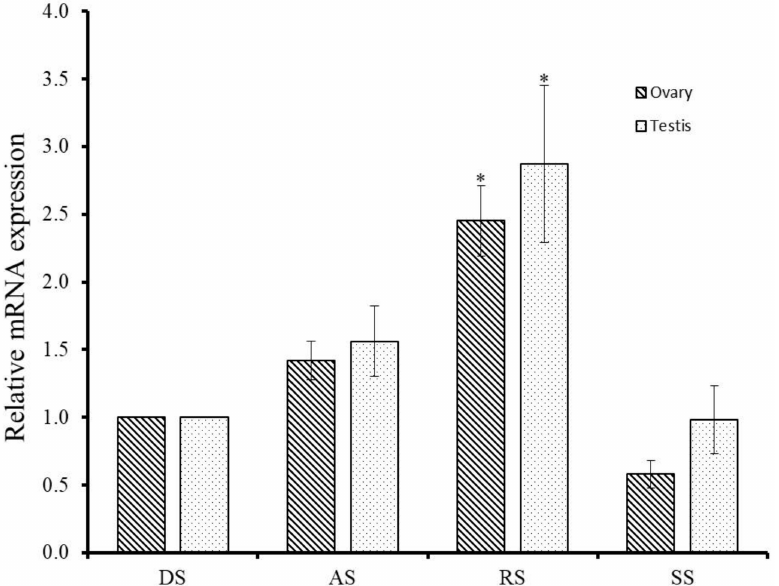
Figure 5. Relative mRNA expression of H. discus hannai GnRH-R mRNA in gonads at di ff erent stages of reproduction. The expression level in the gonad at degenerative stage is set as 1 to calibrate the expression levels in gonad at other stages. Asterisks indicate significant di ff erences ( p ≤ 0.05) when compared with the degenerative stage of gonad. DS-Degenerative stage; AS-Active stage; RS-Ripening stage; SS-Spent